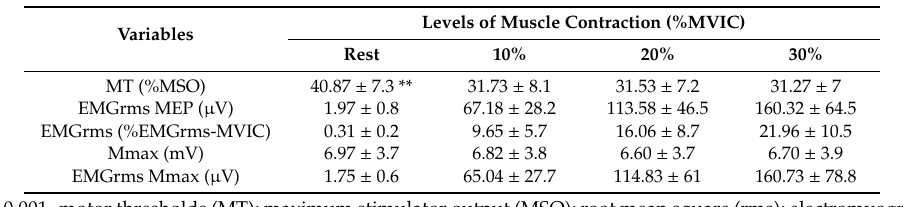
Table 1. Comparison of motor thresholds (MT) (%maximum stimulator output (MSO)), single- and paired-pulse TMS raw EMG rms for MEP data ( µ V), EMG rms expressed as a% of EMG rms obtained during MVIC; Mmax amplitude (mV) and raw EMG rms for Mmax data ( µ V) across levels of